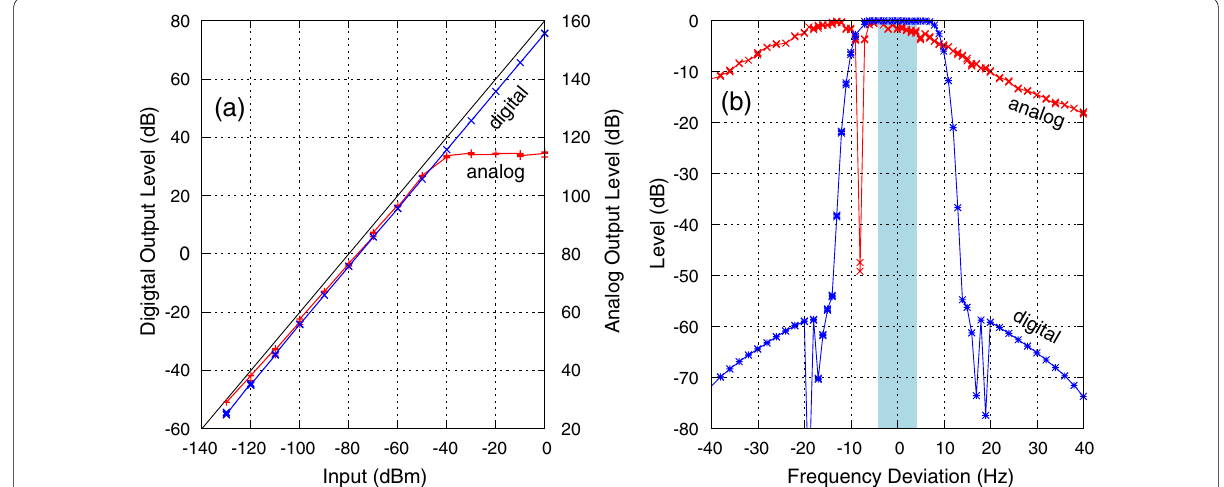
Fig. 6 a Output responses of the analog and digital receivers to input signal level (blue: digital, red: analog). The left-hand and right-hand vertical axes show the digital and analog output level, respectively. The black line shows the ideal linear response. b Transmission characteristics of the filters of analog and digital receivers using the 8006 kHz channel. The blue shaded region shows the bandwidth of the frequency range of the provided Doppler frequency data in the web page of the project (from – 4 to 4